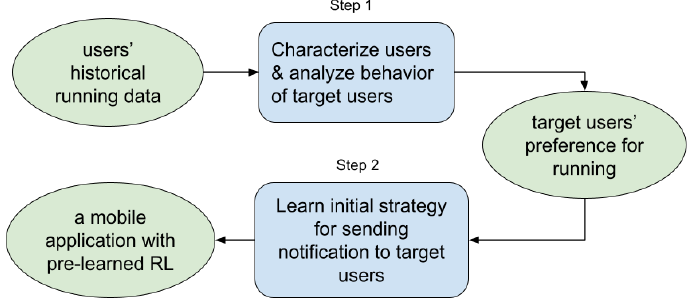
Figure 3. The overall framework for our pre-learned RL exercise